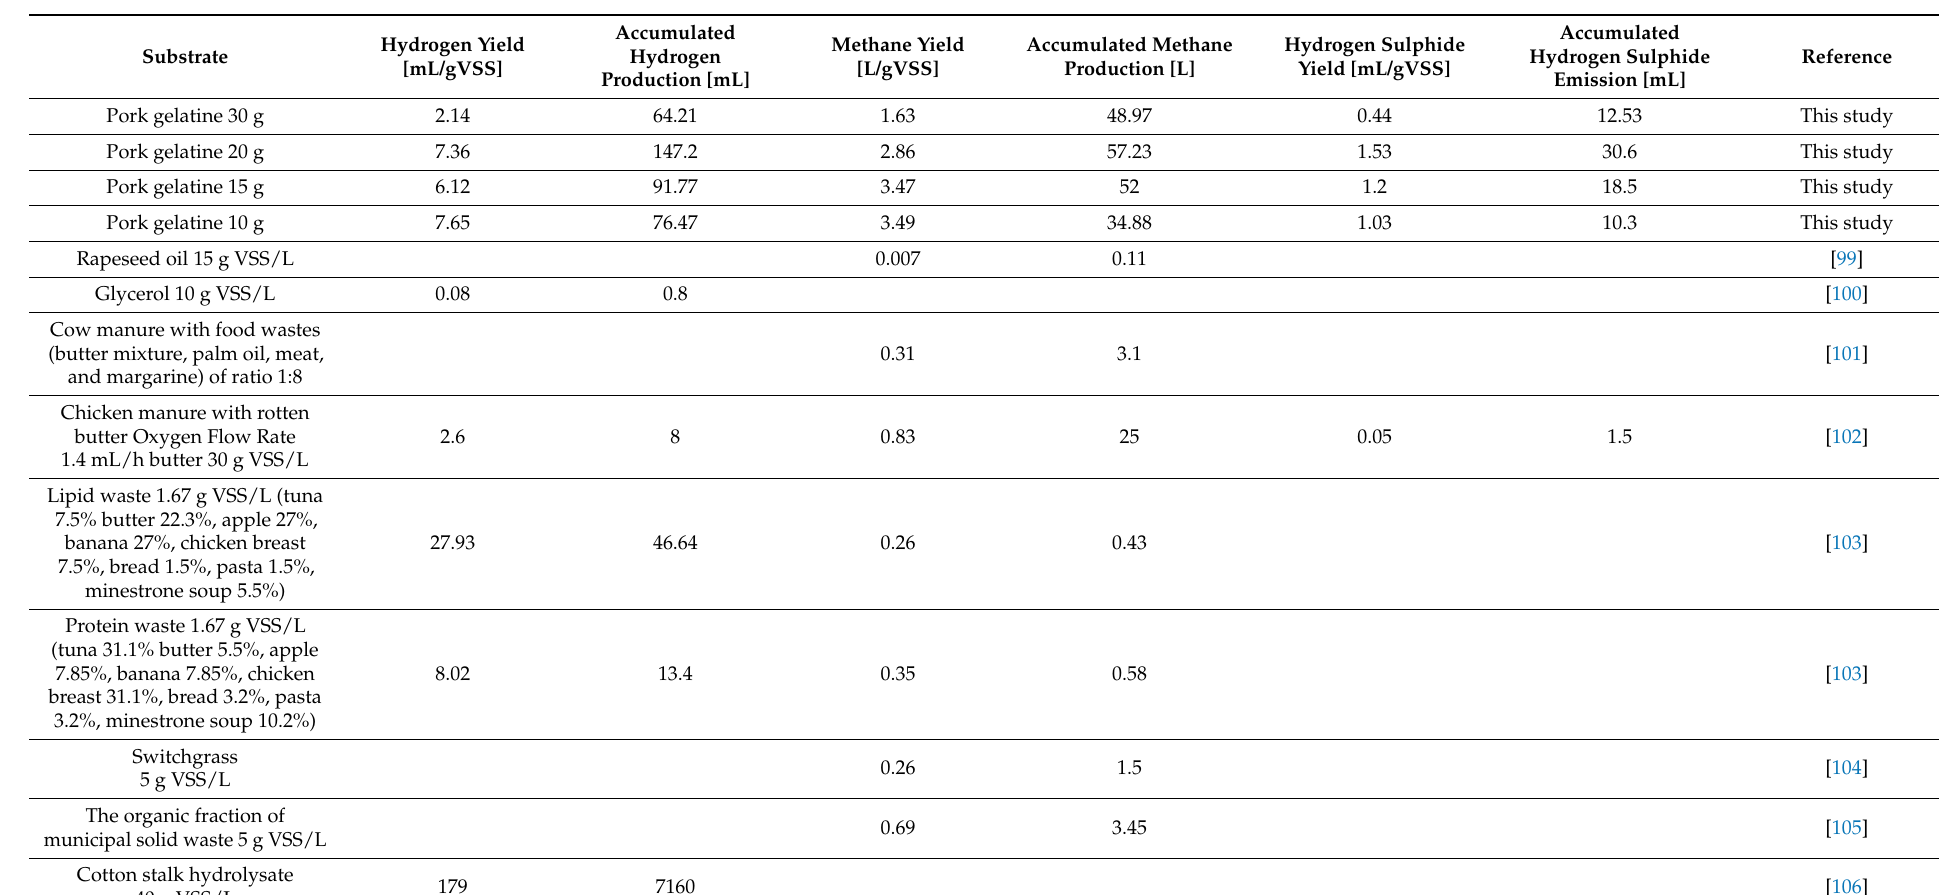
Table 4. Comparison of hydrogen and methane yield from gelatine and substrates found in